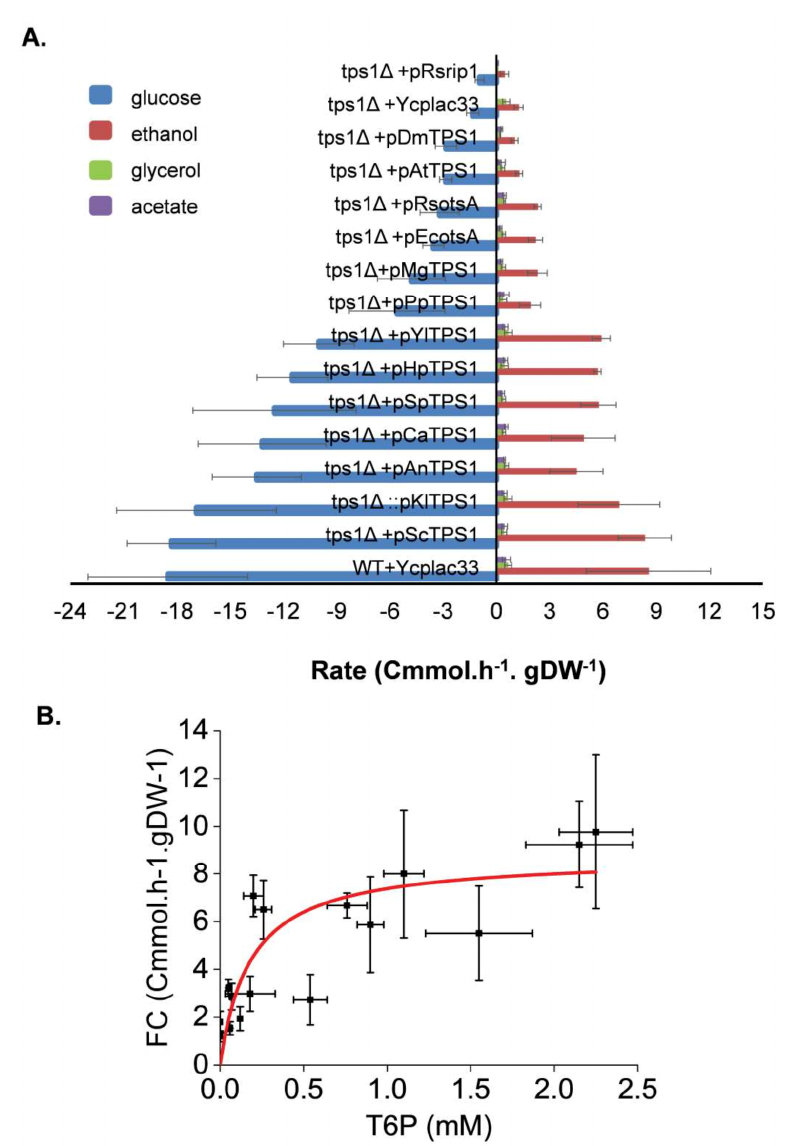
FIGURE 7: Determination of the fermenta- tion capacity of S. cerevisiae tps1 mutant complemented with TPS1 from different origins. The experimental design was as described in Fig.3 except that the supernatants of the cultures were taken at 5 min interval after glucose addition for 60 min. Exo-metabolites determined by HPLC were expressed as Cmmol consumed (glucose) or produced (ethanol, acetate and glycerol) per h -1 and per g DCW -1 . Results shown are the mean of three independent experiments with standard deviation bars (A) . In (B) , Relationship be- tween fermentation capacity (FC) and T6P level. The Origin 2018 software (OriginLab, https://www.originlab.com/) was used to fit